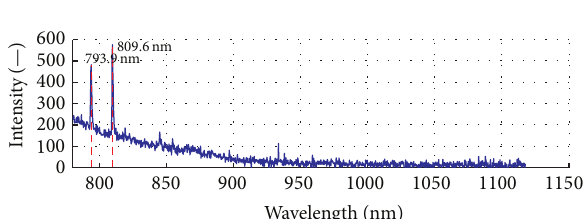
Figure 5: Spectral distribution depicting dominant components within the UV range.